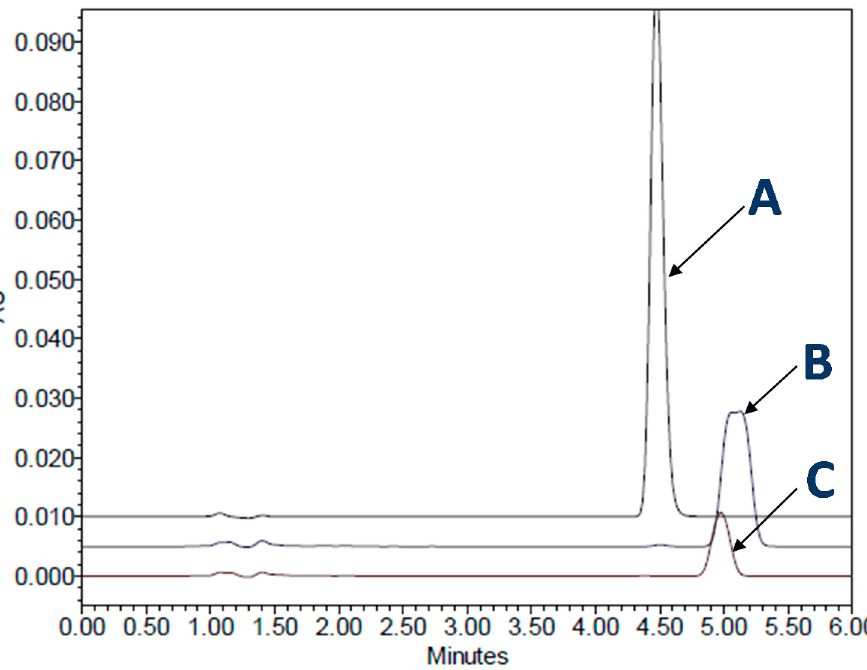
Figure 7. HPLC chromatograms of loratadine in 0.1 N HCl in purified water + 0.1 % SLS: ( A ) represents loratadine standard in 0.1N HCl, ( B ) loratadine soft gelatin capsule in 0.1 N HCl + 0.1% SLS dissolution media after 10 min, and ( C ) loratadine soft gelatin capsule in dissolution media with SLS after 60 min. Chromatographic conditions were done as described by Damian et al. [63].